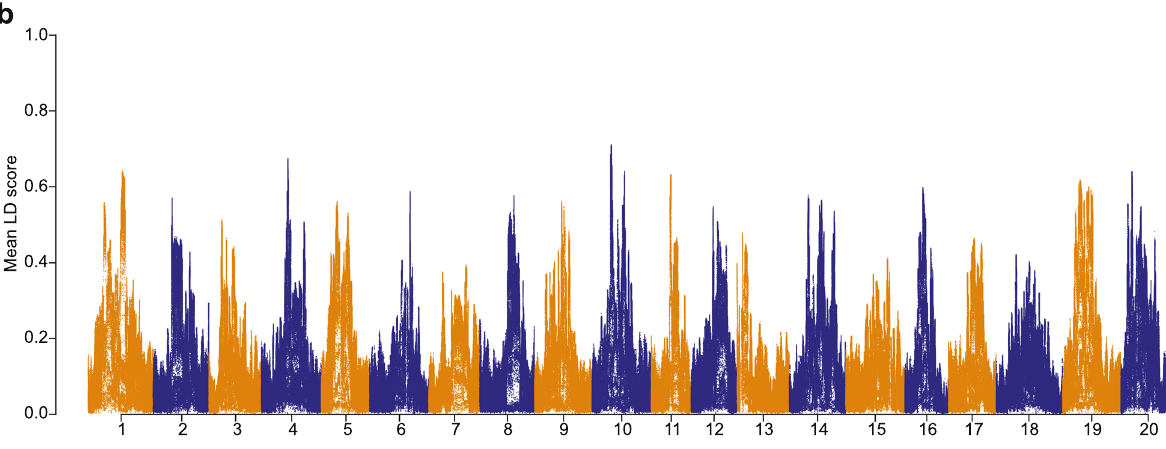
Fig. 2 Genomic landscape of soybean. a Chromosomes based on the Williams 82 reference genome sequence v. Wm82.a2.v1 (a). Centromere repeat regions are indicated by gray bands. Gene density heatmap (b). SNP density (c). Indel density (d). Population recombination rates calculated in 1 Mb windows (blue = historical recombination rate and red = estimates of recombination rate from mapping populations (e). SV density (f). Average GERP score density (>0), with dark blue of high GERP score (g). All window sizes are 100 kb except recombination rates. b Mean LD scores estimated with a 1 Mb